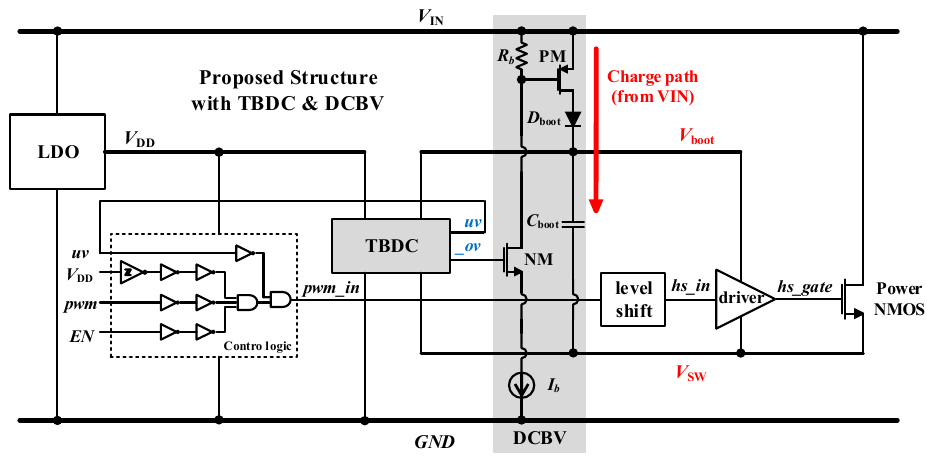
Figure 2. Proposed bootstrap structure with TBDC and DCBV.